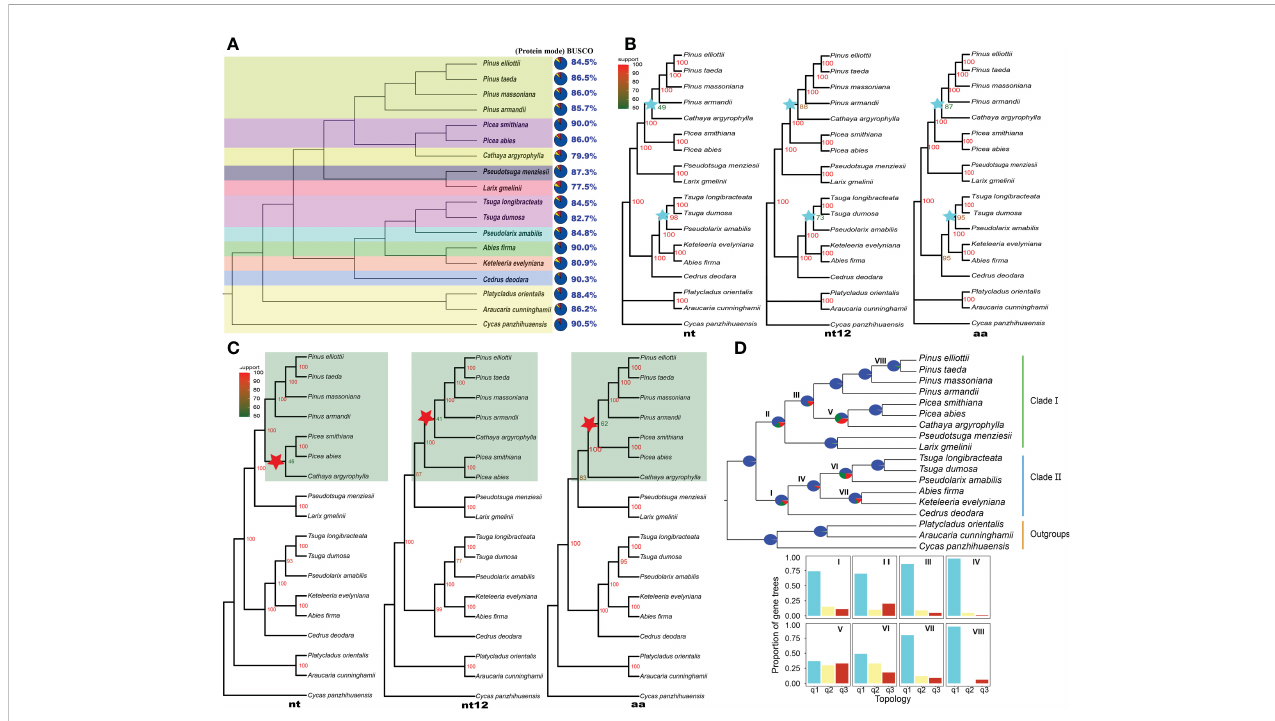
FIGURE 1 Topology and gene tree con fl ict analysis of Pinaceae. (A) The assessment of annotation completeness based on 1614 benchmarking universal single- copy orthologs (BUSCOs) using protein mode. The colors of the pies refer to complete BUSCOs (steel blue), fragmented BUSCOs (yellow), and missing BUSCOs (red). (B) Concatenated ML trees inferred based on 54 single-copy orthologous genes; nt, nucleotide sequences; nt12, 1st+2nd codon positions; aa, amino acid sequences. IQ-TREE maximum likelihood bootstrap support values are indicated above the branches. (C) ASTRAL